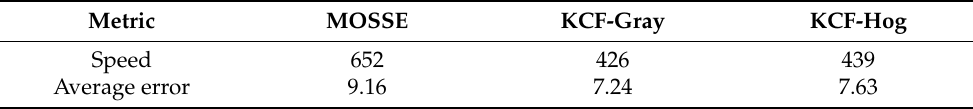
Table 1. Average speed and error of pupil tracking. Metric